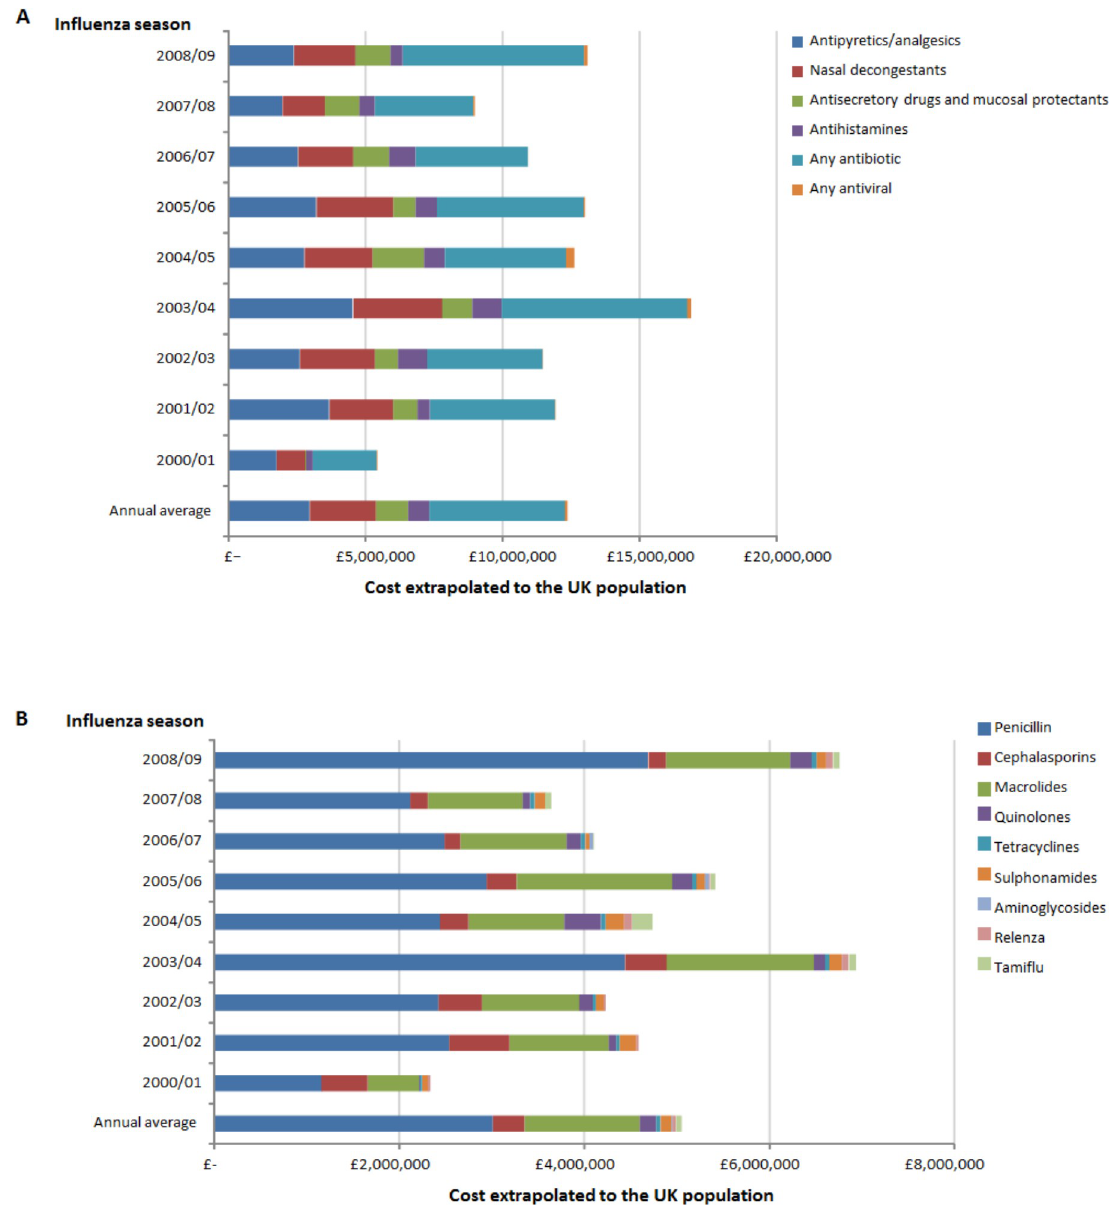
Fig 2. Prescriptions by medication class (A) and antibiotic and antiviral use (B) for acute respiratory illness in the CPRD by influenza season extrapolated to the UK population for corresponding years.CPRD, Clinical Practice Research